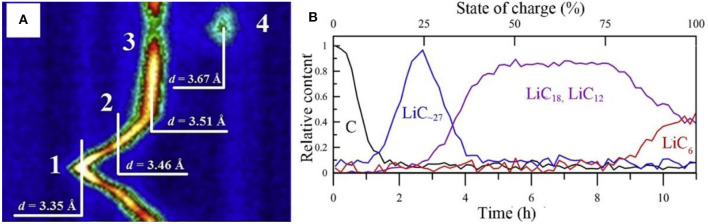
(A) 2D diffraction pattern region characterizing structural processes in LFP-battery anode. Initial state of the anode graphite without lithium (1, d = 3.35 Å), and sequentially emerging phases LiC~27 (2, d = 3.46 Å), LiC18, LiC12 (3, d = 3.51 Å), and LiC6 (4, d = 3.67 Å) for battery. (B) Content of different LiCx phases of battery in course of one charge cycle as a function of time (lower scale) or SOC (upper scale) recovered from relative changes in intensity of corresponding diffraction peaks (Bobrikov et al., 2014).